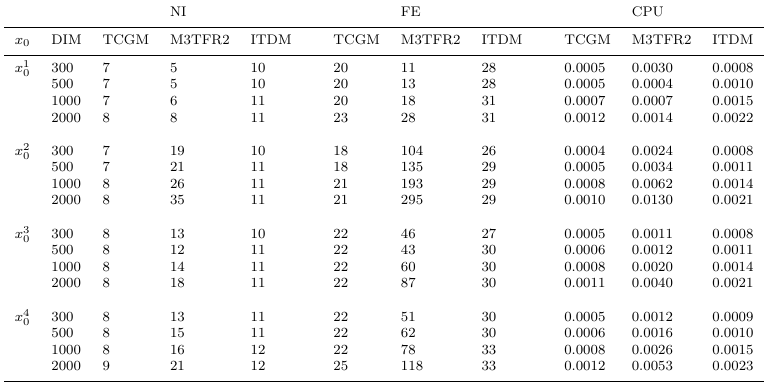
Table 4. Numerical results of Problem 4.